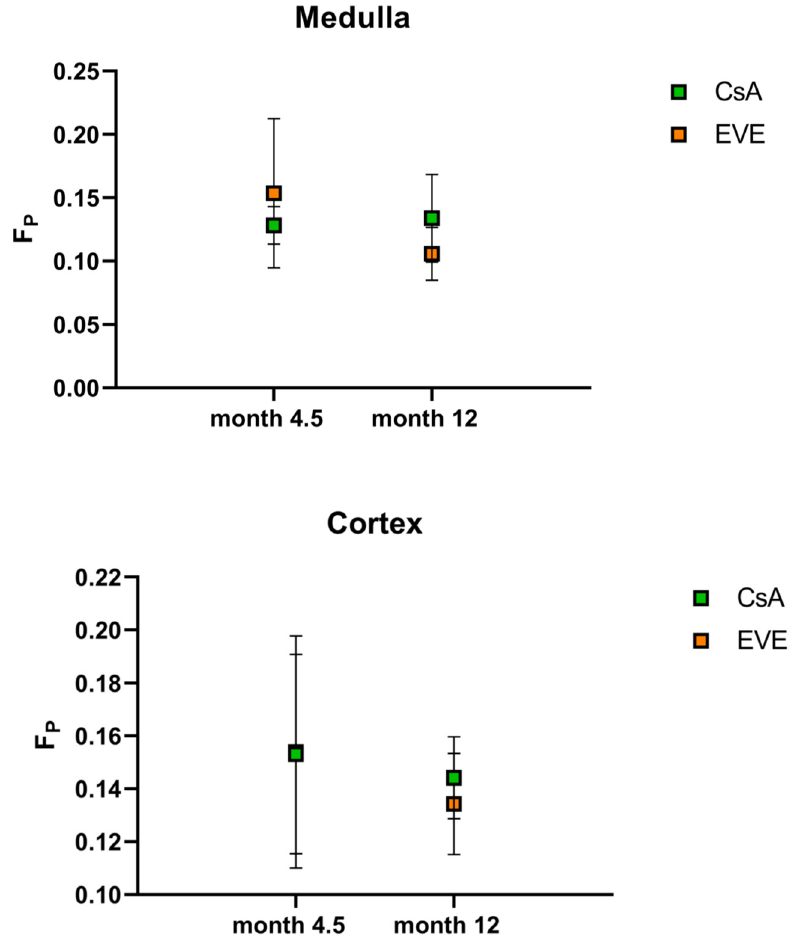
Figure 5. DWI-derived perfusion fraction. Perfusion fraction F P according to medication group and time-point in medulla and time-point in medulla and cortex.